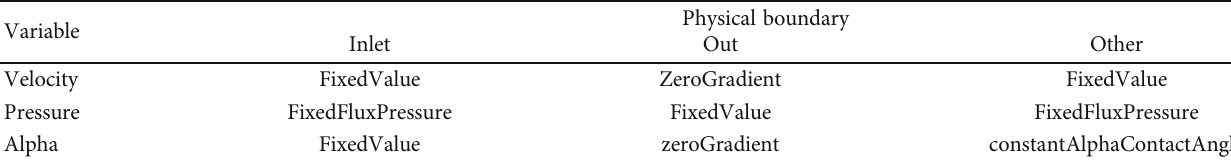
Table 3: Boundary